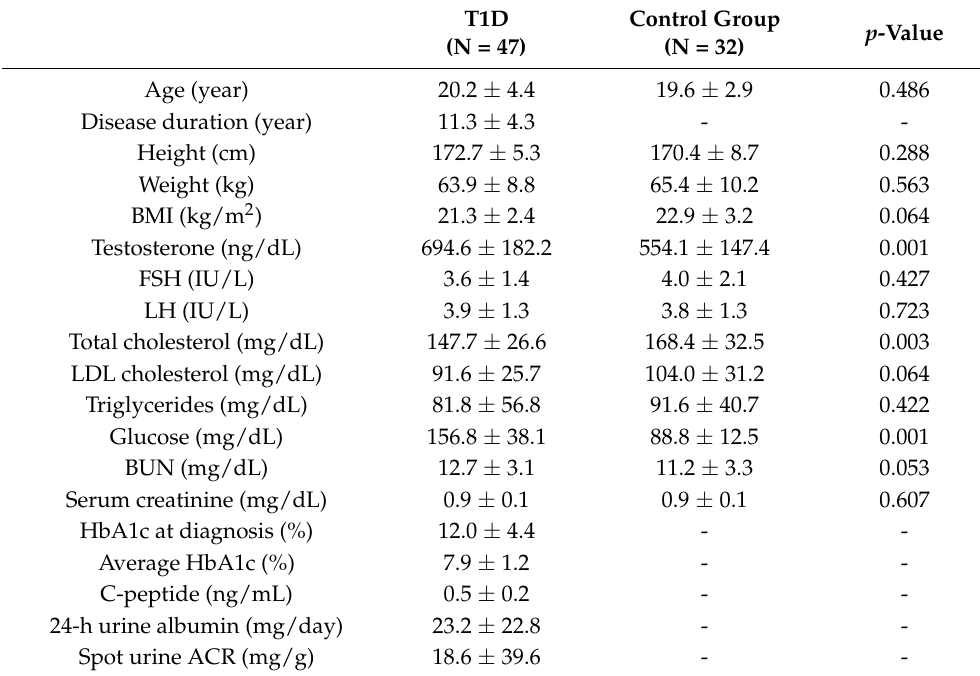
Table 1. Comparison of baseline characteristics between the type 1 diabetes and control groups.